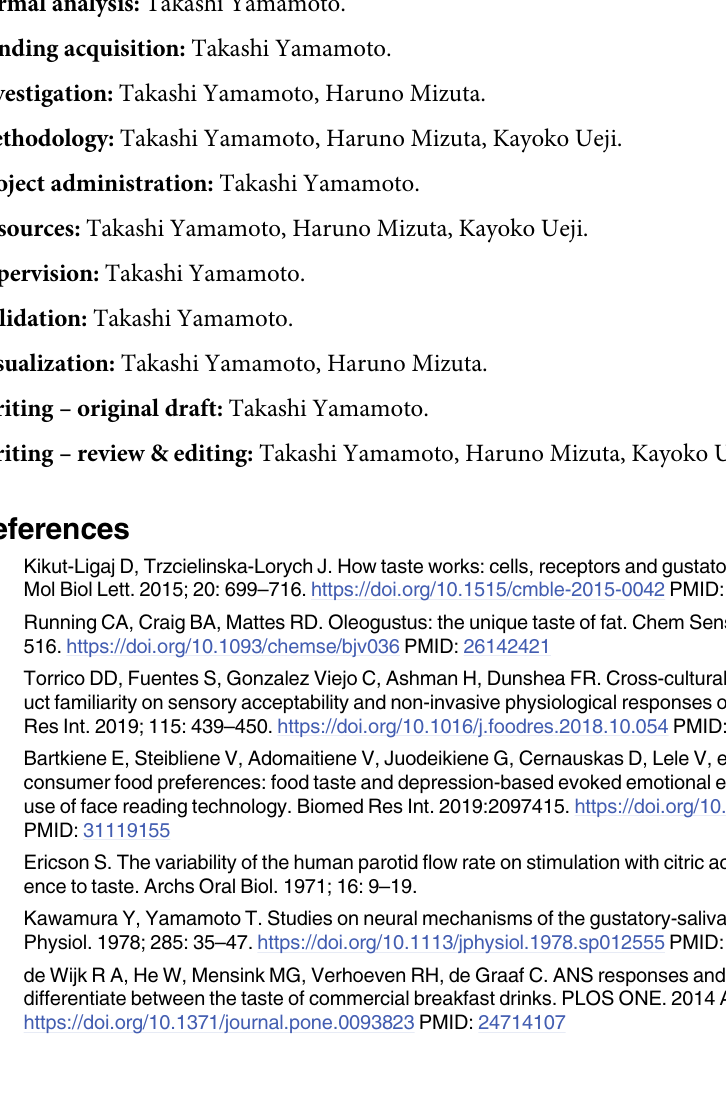
S1 Table. Raw data for Fig 1. S2 Table. Raw data for Figs 4 and